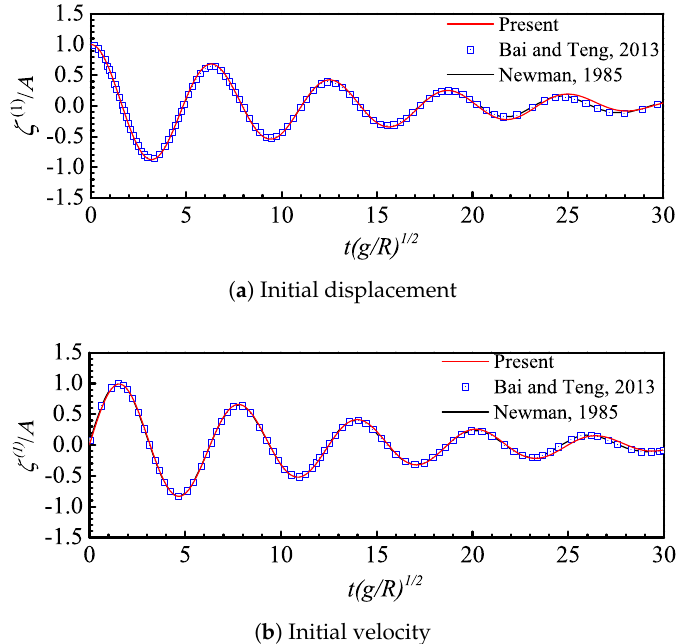
Figure 5. Time history of vertical displacement of a freely floating truncated vertical cylinder specifying initial